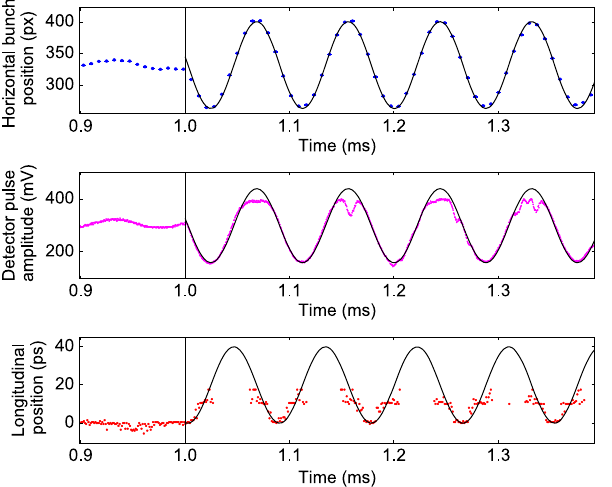
mA.FIG. 6. Signature of the triggered rf phase-step seen by the different systems. Top: Horizontal bunch position from the FGC. Center: Signal of the incoherent synchrotron radiation recorded using an optical APD and KAPTURE. Bottom: Arrival time of the bunch recorded with KALYPSO. It is defined by the position of the maximum electro-optical modulation. The vertical line in all plots marks the rf phase step triggering the onset of a synchrotron oscillation. As a guide to the eye the plots contain a sinusoidal curve at the synchrotron